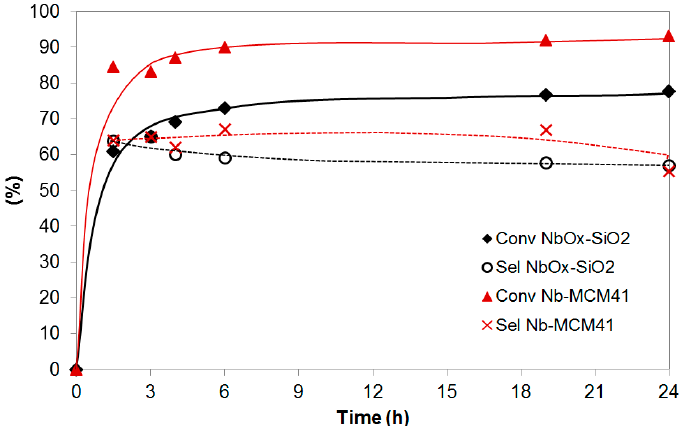
Figure 7. Conversion of C = C double bonds of karanja FAME mixture (solid lines) and selectivity to monoepoxides (dashed lines) vs. time over NbO x -SiO 2 (black symbols) and Nb-MCM-41 (red symbols). Reaction conditions: glass batch reactor, 100 mg catalyst, 1 mmol C = C substrate, 4 mmol aq. H 2 O 2 , 90 °C, 300 rpm, 5 mL CH 3 CN.